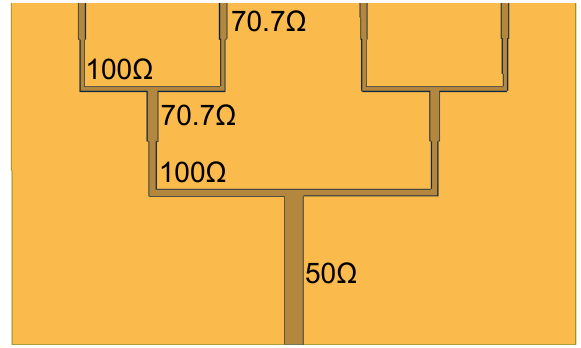
Figure 10. Feeding network of the AVA